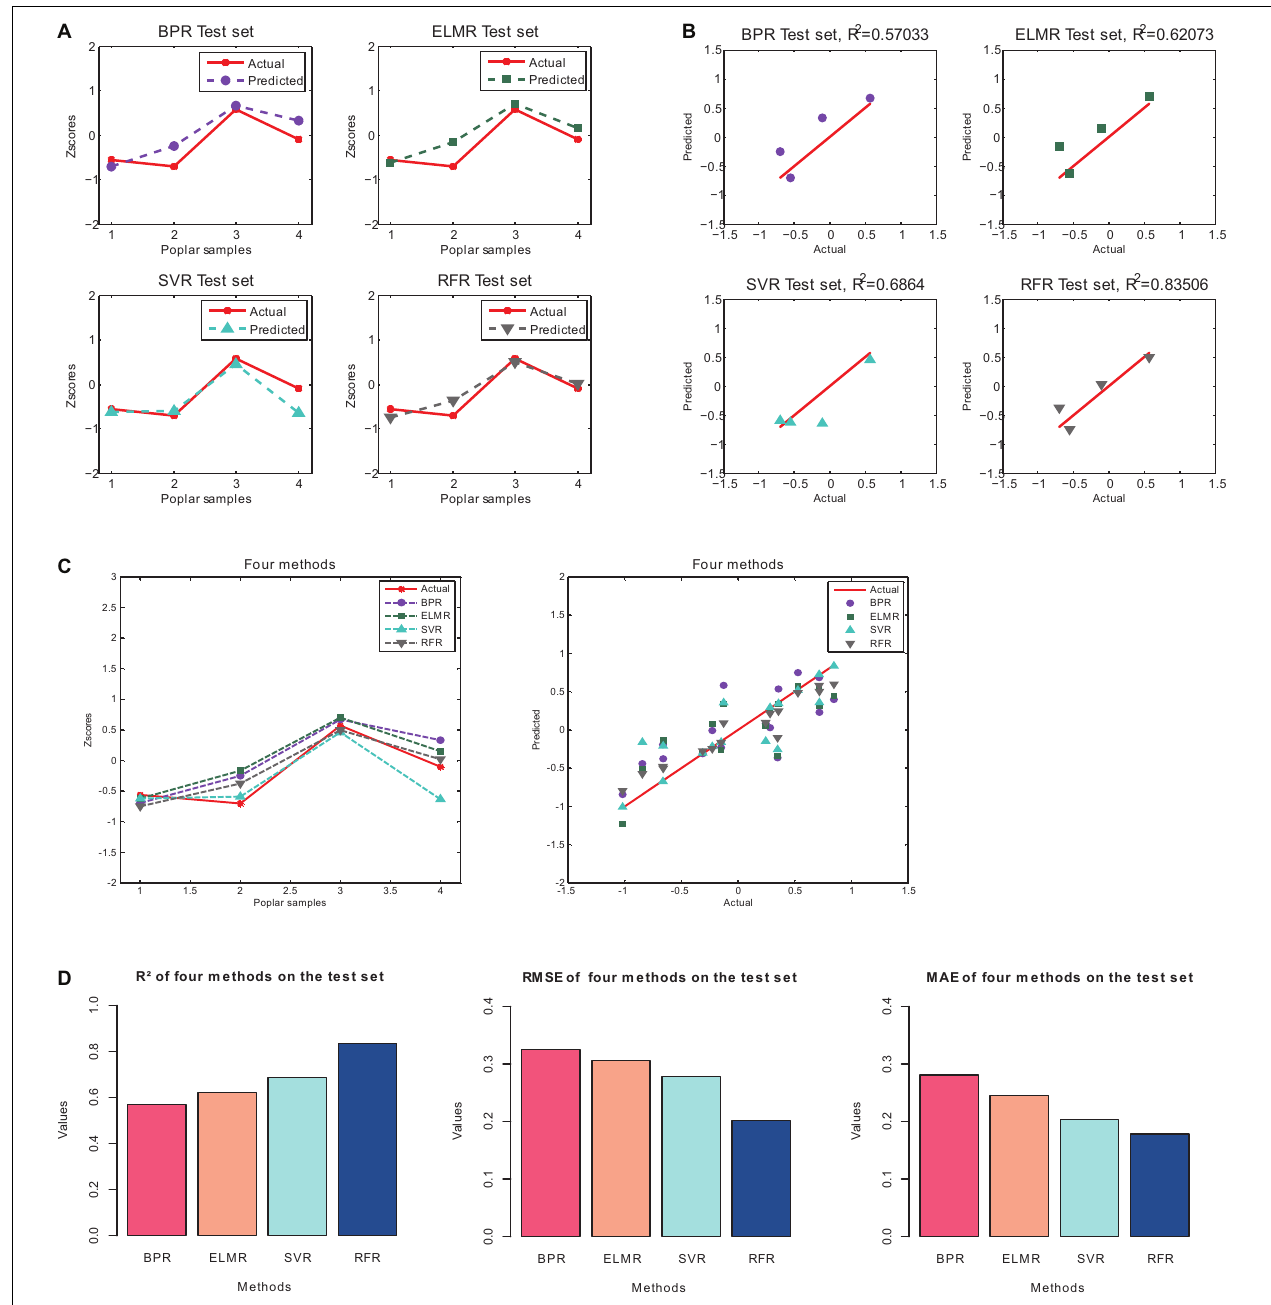
FIGURE 7 | The regression results of the four machine learning methods on the test set. (A) Results of Predicted. (B) Predicted and actual value. (C) Comparison of results of four methods. (D) The R 2 , RMSE and MAE of the four machine learning methods on the test